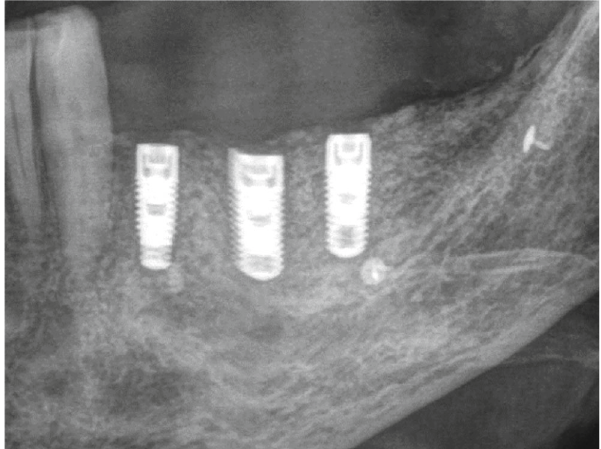
Figure 25: DPT — section; Tapered Screw Vent TSVT MTX Zimmer Biomet ™ implants inserted in region 34, 35, and